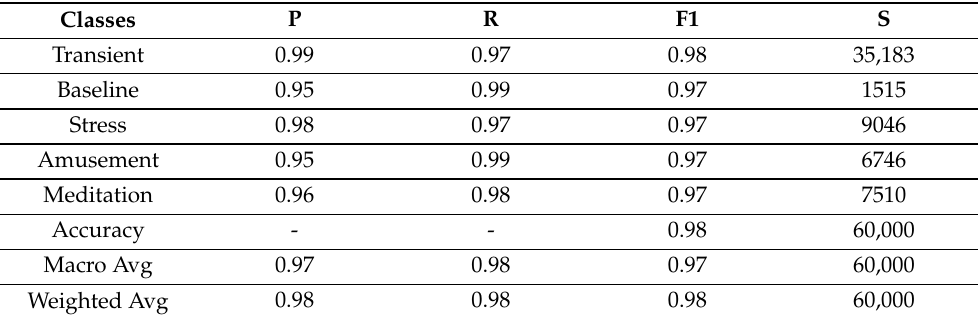
Table 4. Proposed model result of Client 2 for round 1. Key: Precision-P; Recall-R; F1-score-F1; S-Support.